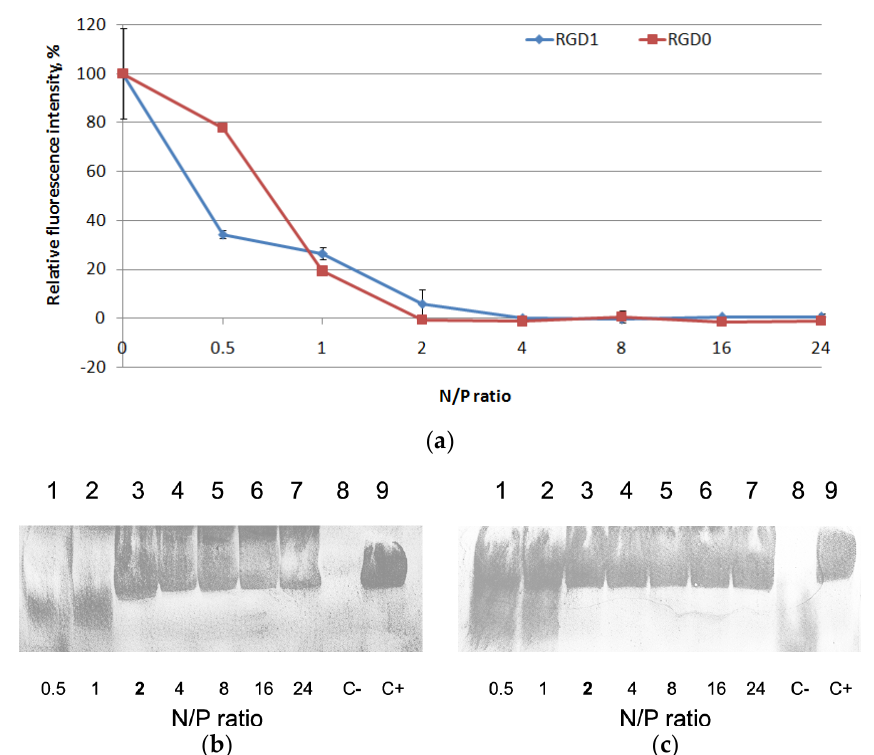
Figure 3. SybrGreen exclusion from complexes of siRNA and RGD1 and RGD0 carriers ( a ). A total of 100% of fluorescence intensity corresponds to free siRNA stained with SybrGreen. The data are shown as the mean ± SD RNase A protective ability of siRNA-complexes formed with RGD1 ( b ) and RGD0 ( c ) peptides. The polyplexes containing 0.2 μg of siRNA were treated with 100 ng of RNase A for 30 min at 37 °C. C− is siRNA treated with RNase A; C+ is untreated siRNA. N/P ratio number in bold indicates full defense from RNase A.